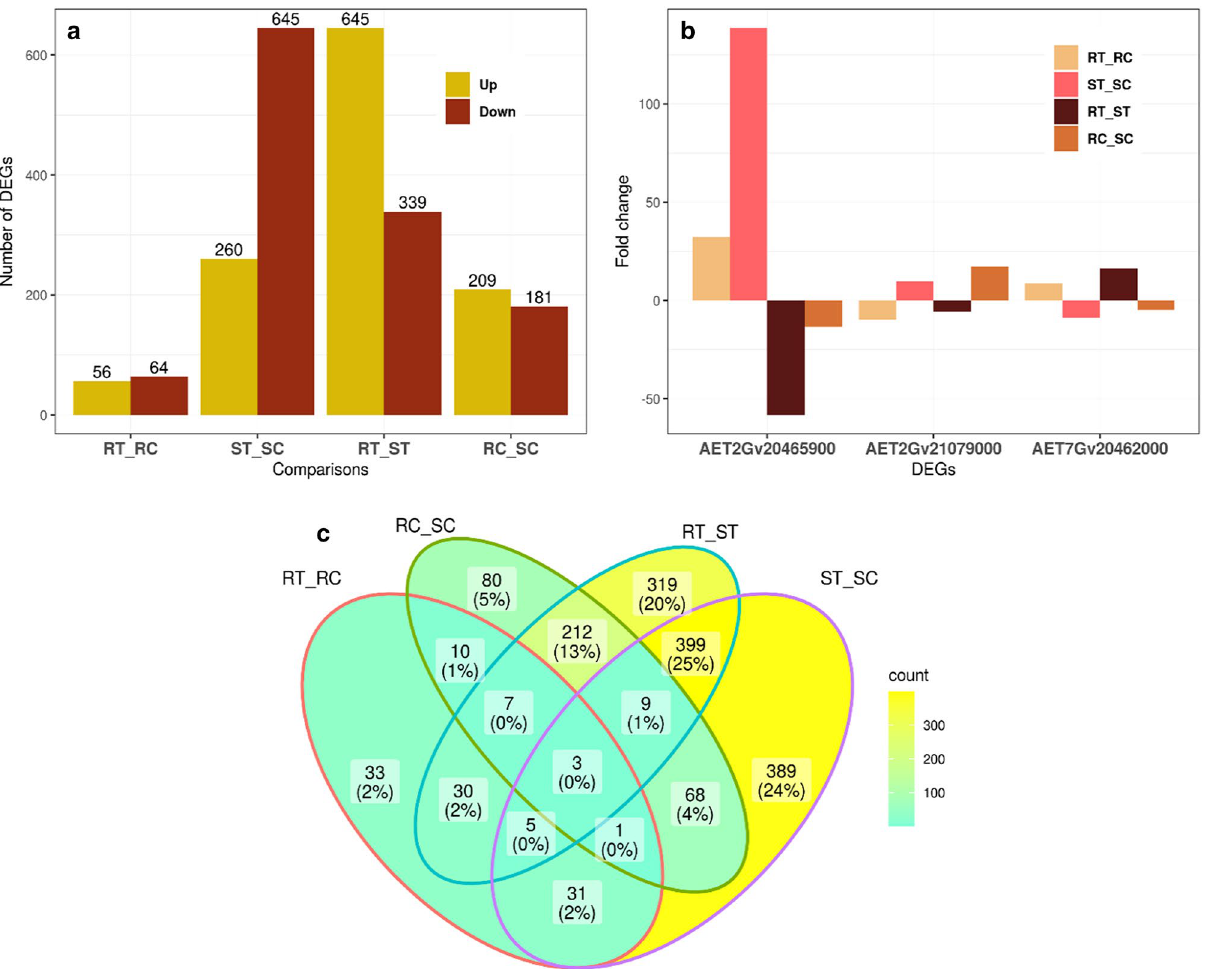
Figure 6. Summary of differentially expressed genes (DEGs) in four comparisons. RC (resistant control), RT (resistant treatment), SC (susceptible control), and ST (susceptible treatment). ( a ) Up and down-regulated DEG statistics in different comparisons of the resistant or susceptible Ae. tauschii accessions (AT349 or AT350) with/out P. triticina infection, ( b ) Fold-changes of three common DEGs among all comparisons. ( c ) The Venn diagram exhibits the distribution of DEGs in different comparisons. 6a and 6b were created using ‘ggplot2 version 3.3.5’ R/CRAN package https:// ggplo t2. tidyv erse. org) while, 6c was created using ‘ggVennDiagram version 1.2.0’ R/CRAN package (https:// github. com/ gaosp ecial/ ggVen nDiag